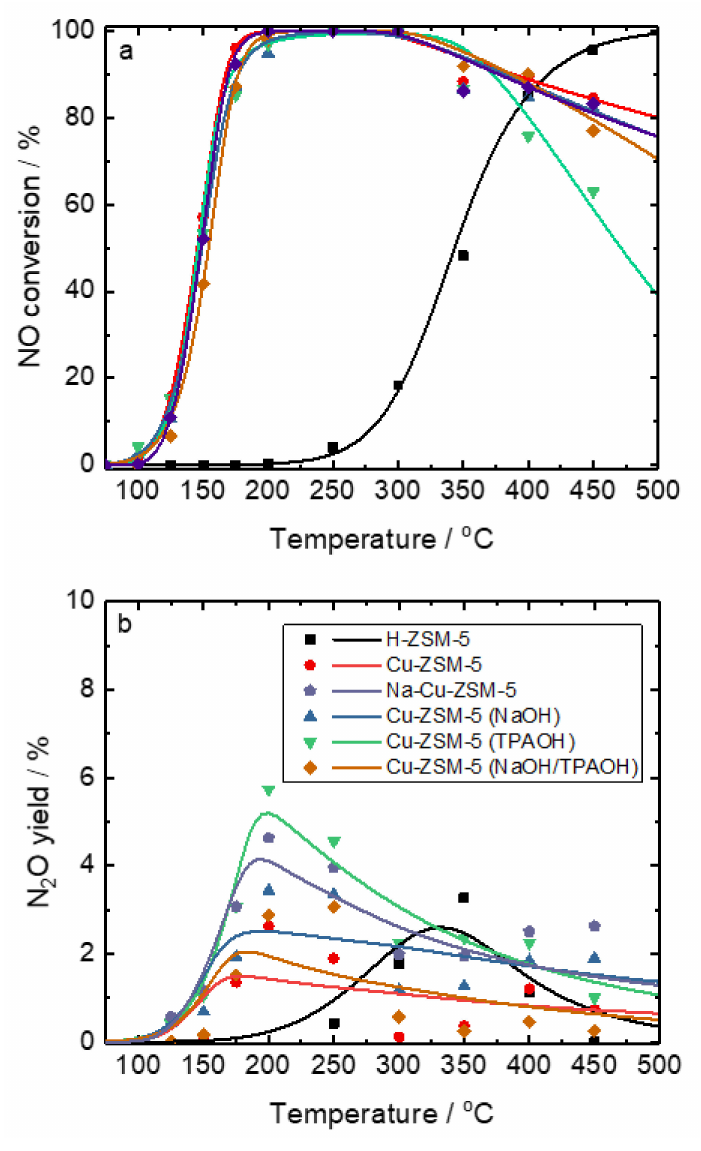
Figure 11. Experimental (points) and modeling (lines) results of catalytic studies: ( a ) NO conversion and ( b ) N 2 O yield (reaction conditions: 0.2 g of catalyst, 120 mL min − 1 , 500 ppm NO, 575 ppm NH 3 , 4 vol.% O 2 and He balance, GHSV = 30,000 h − 1